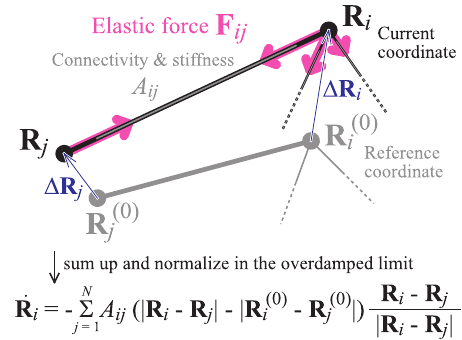
Figure 1. Schematic diagram of the elastic network model (ENM). Each spring ( i , j ) obeys Hooke’s law; i.e., the strength of its elastic force F ij is proportional to its deformation from the equilibrium length, and the force direction coincides with the spring direction. The resultant force F i on particle i is the sum of forces F ij exerted by all the springs connected to the particle. In dynamic simulations in the overdamped limit (Section 2.4), the velocity ˙ R i of particle i is directly calculated from F i . Adapted from